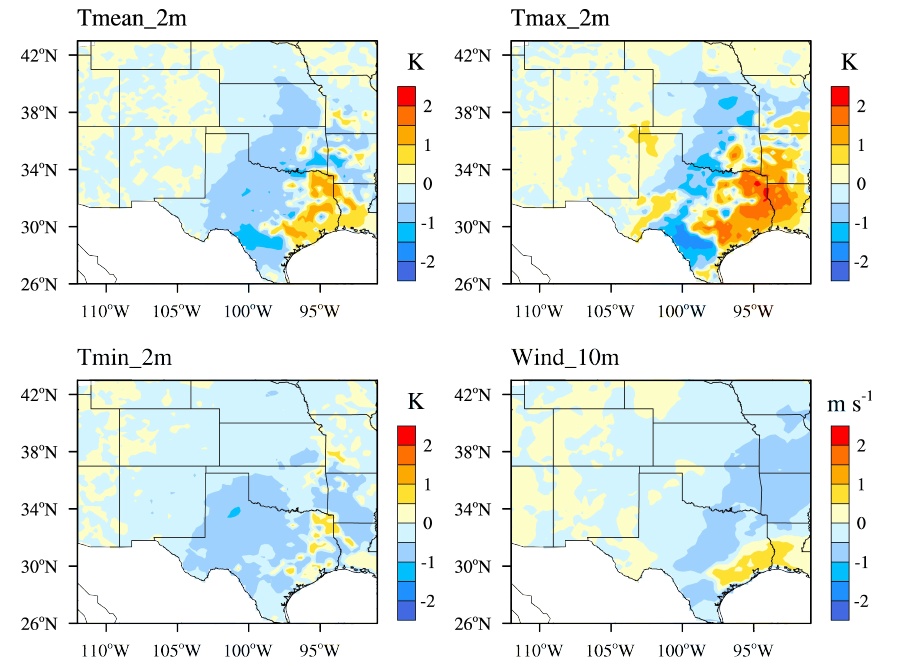
Fig. 11. The spatial distributions of the differences of model biases for temperatures and wind speed between the simulations (25-km) with the default and optimized parameters. Here, the value on each grid point is calculated as ( | Optimal-Observation |−| Default-Observation | ) , so negative value represents a positive impact by using optimized